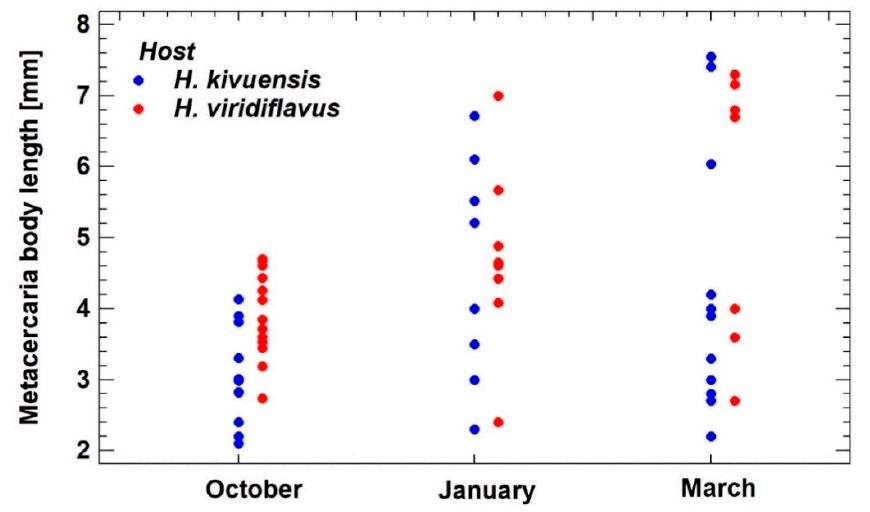
Figure 8. Seasonal body length variation of metacercaria size collected from reed frogs at Huye. Each dot represents one specimen. At each sampling date, specimens originating from 3–5 host frogs per species were measured.